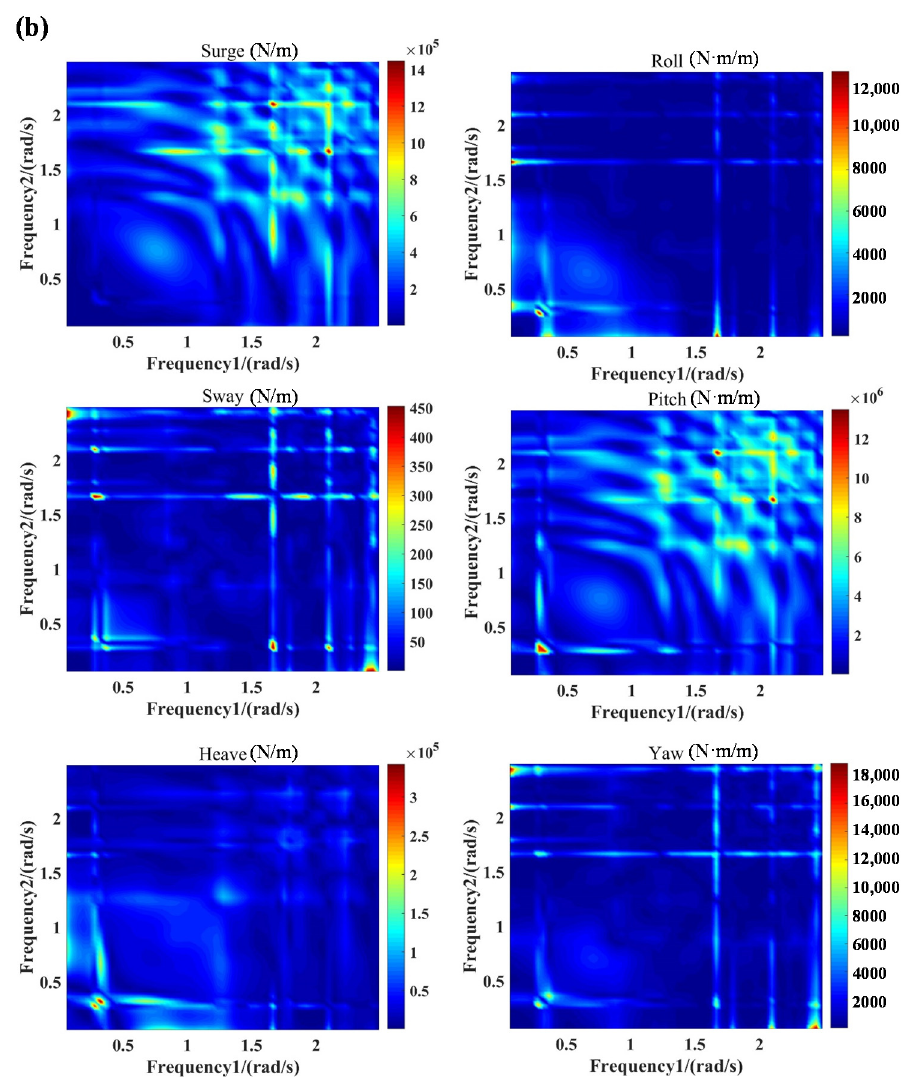
Figure 5. Second-order wave excitation forces and moments at zero degree wave heading direction: ( a ) difference-frequency, ( b ) sum-frequency.